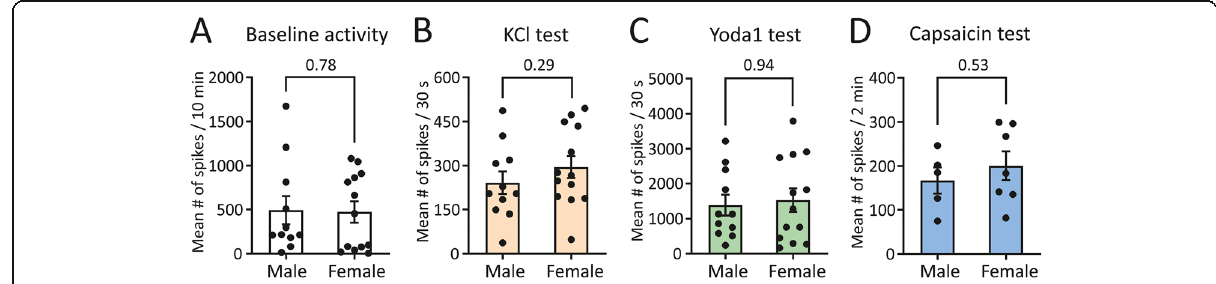
Fig. 4 No sex-difference in general nociceptive fibre excitability, Piezo1 activity and capsaicin sensitivity. (A) Histograms show the mean ± SEM number of nociceptive spikes in control conditions in males ( n = 11) and females ( n = 13) and the lack of a sex difference ( p = 0.78, Mann – Whitney U test). (B) Histograms show the mean ± SEM number of nociceptive spikes during the 30-s active phase of 50 mM KCL application in males ( n = 11) and females ( n = 13) and the lack of a sex difference ( p = 0.29, Mann – Whitney U test). (C) Histograms show the mean ± SEM number of nociceptive spikes during 10-min recordings after application of 5 μ M Yoda1 in males ( n = 11) and females ( n = 13). (D) Histograms show the mean ± SEM number of nociceptive spikes during the 2-min active phase of 1 μ M capsaicin application in males ( n = 5) and females